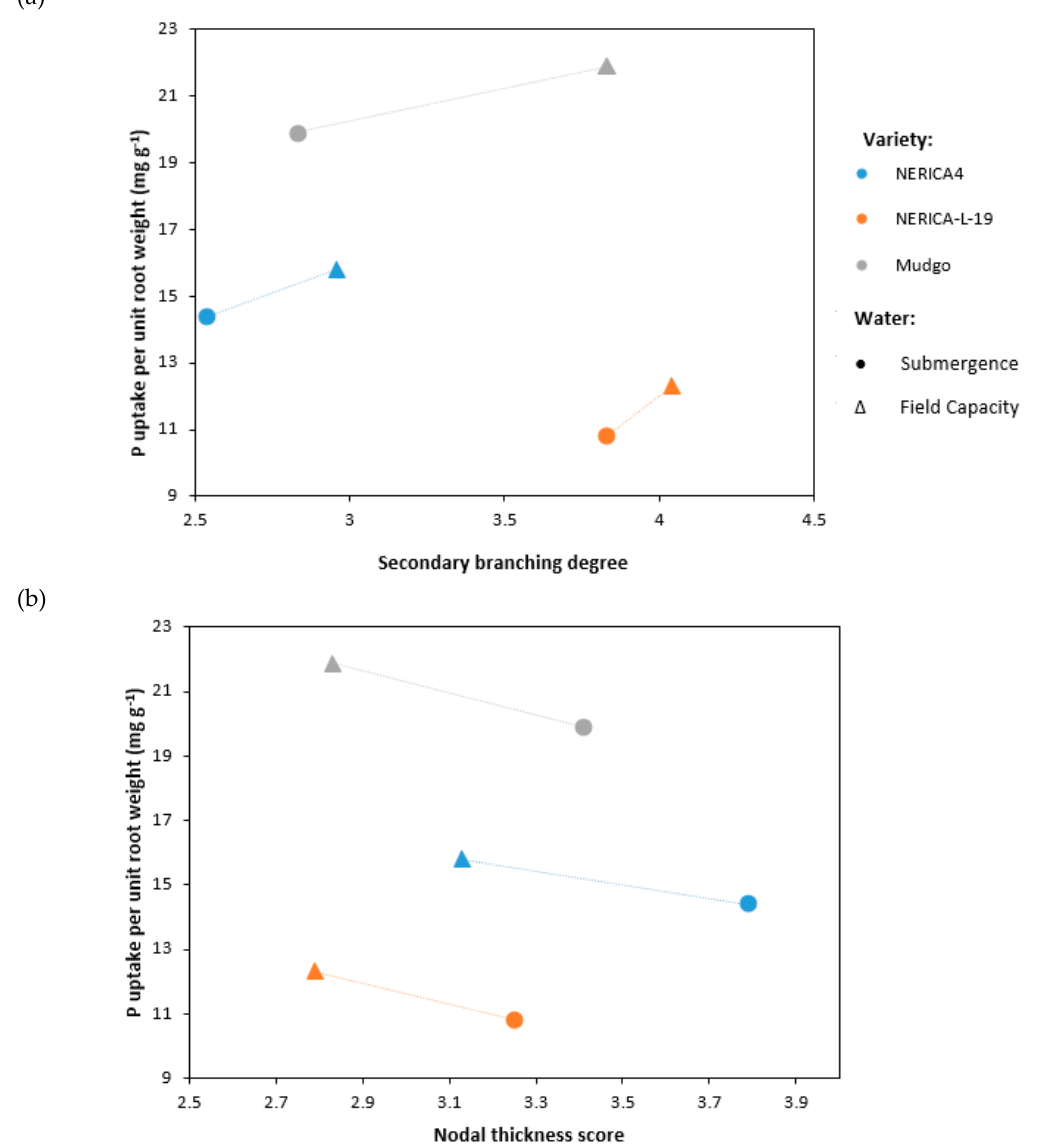
Figure 5. The P uptake (mg) per unit root mass (g) versus the secondary branching degree ( a ), and nodal thickness ( b ) in response to reduced water availability (Soil Submergence versus Field Capacity). Data are presented for three varieties grown on a lowland field without P application.